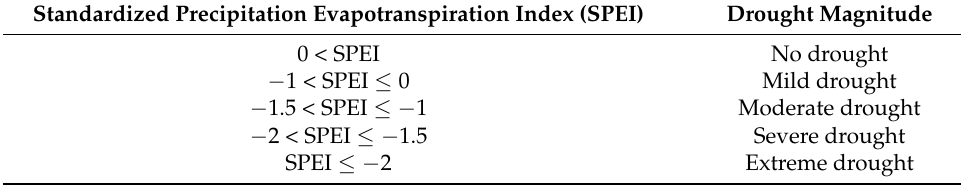
Table 1. Drought classification is based on the standardized precipitation evapotranspiration index